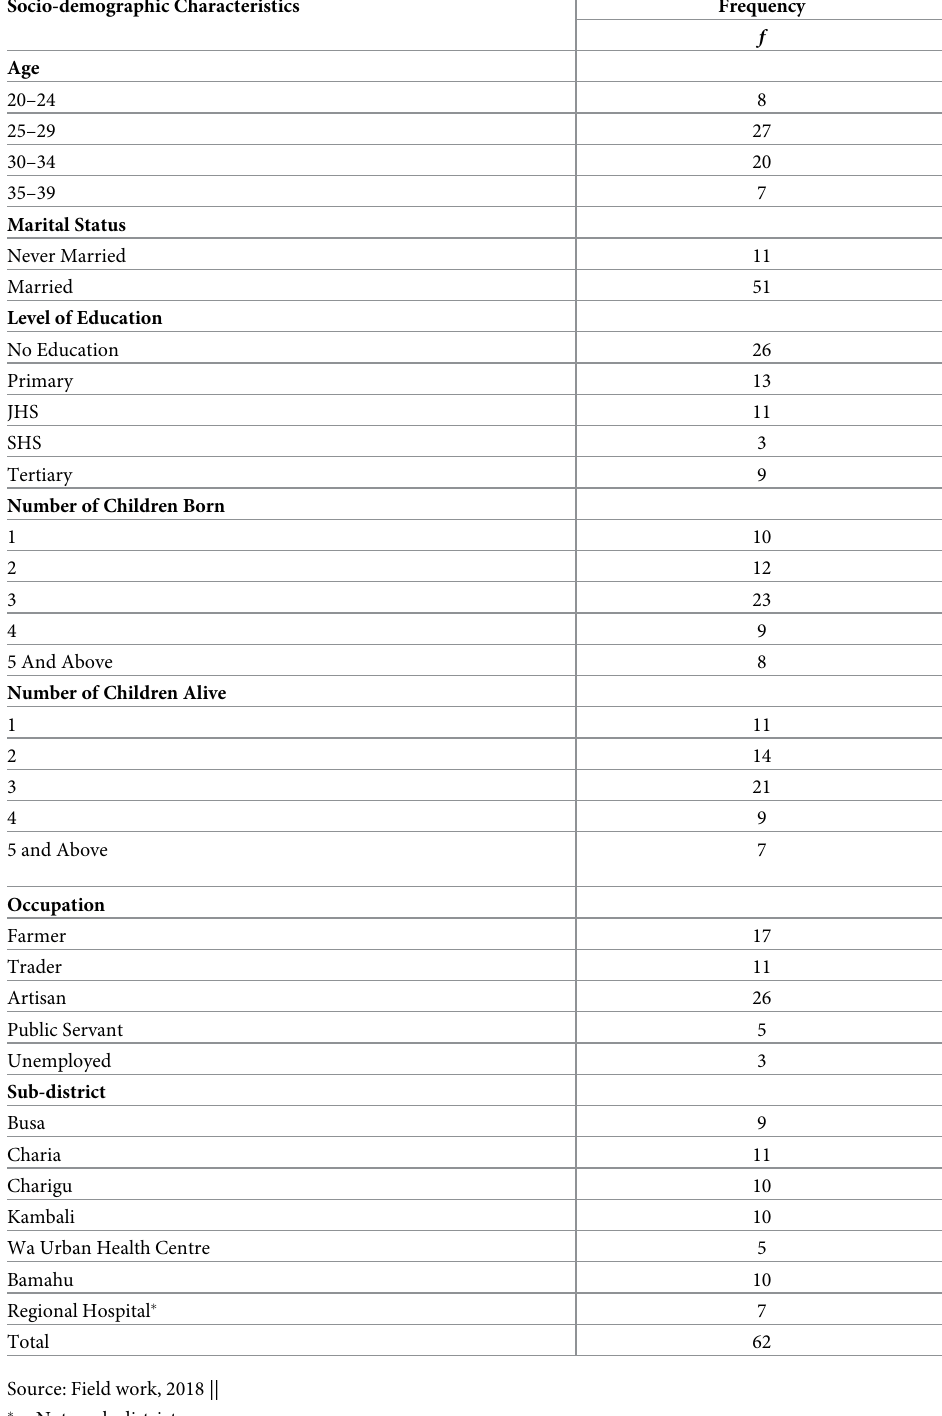
Table 1. Socio-demographic background of the